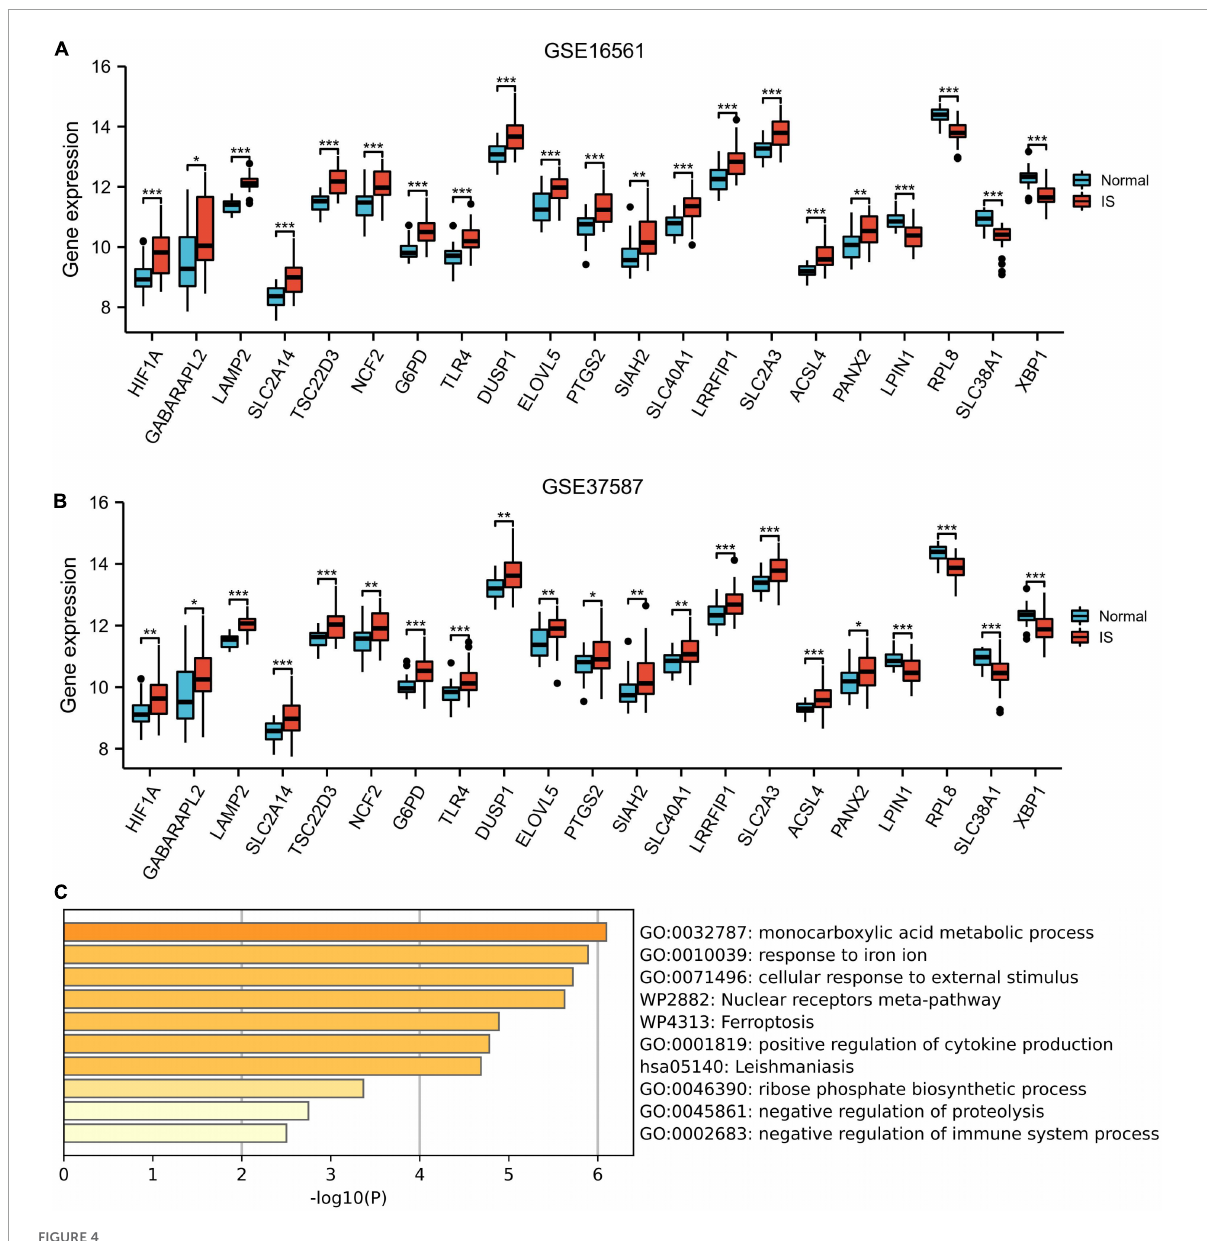
FIGURE4 Enrichment analysis. Box plot described the expression pattern of the 21 ferroptosis-related genes between IS and normal samples in GSE16561 (A) and GSE37587 (B) . (C) 21 ferroptosis-related genes enrichment analysis. IS, ischemic stroke. * p < 0.05, ** p < 0.01, and *** p <